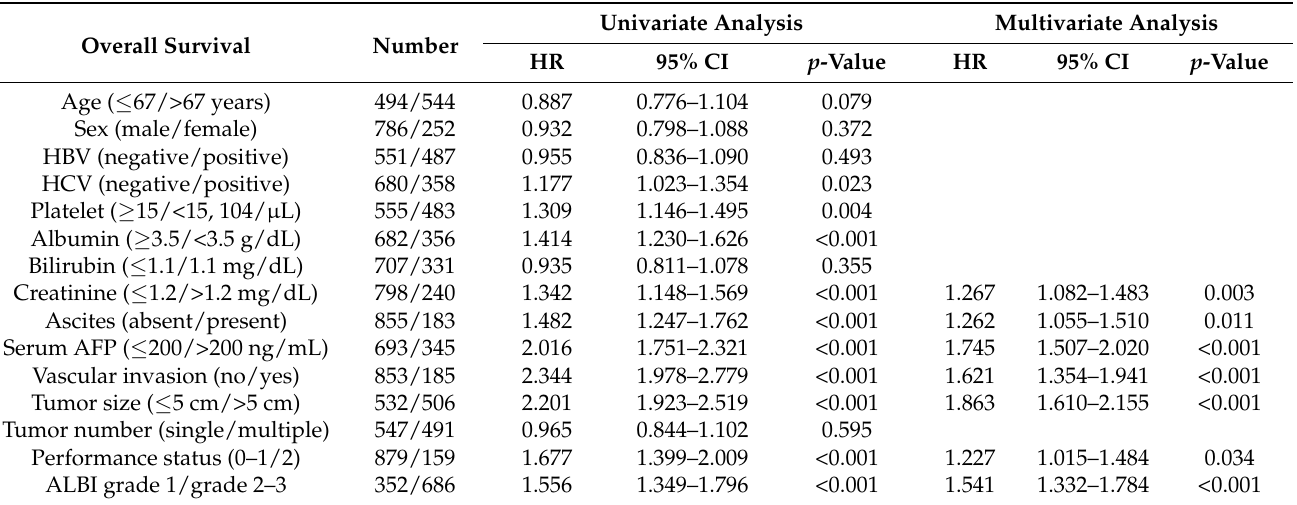
Table 3. Multivariate analysis of overall survival in patients undergoing transarterial chemoemboliza- tion including ALBI grade.